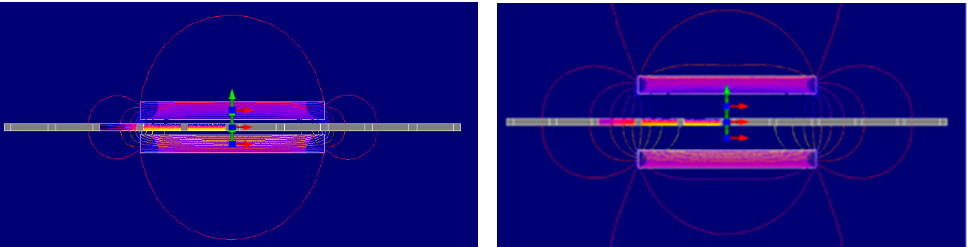
Figure 15. Distribution of magnetic flux lines in the active rotor area—Gadolinium (Gd) in the ferromagnetic state (cold).